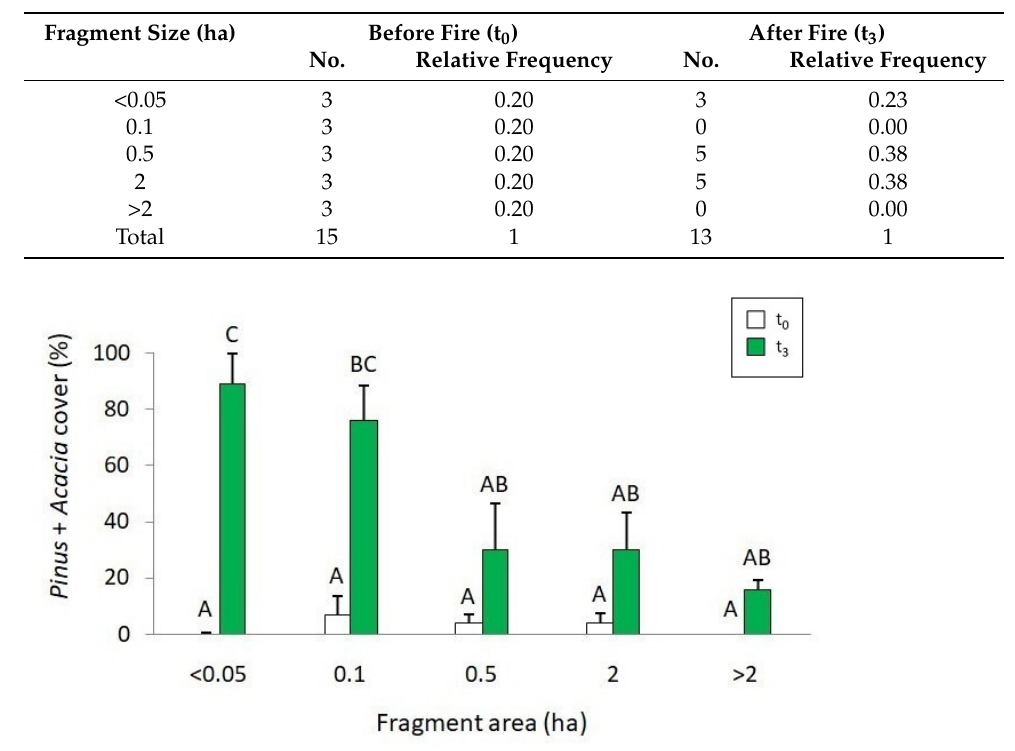
Figure 4. Comparison between the percentage cover of P. pinaster and A. longifolia in grassland fragments of different size at different times in relation to fire (t 0 = white and t 3 = green, before and after fire, respectively). Different letters indicate significant differences ( p < 0.05); bars represent the standard error.